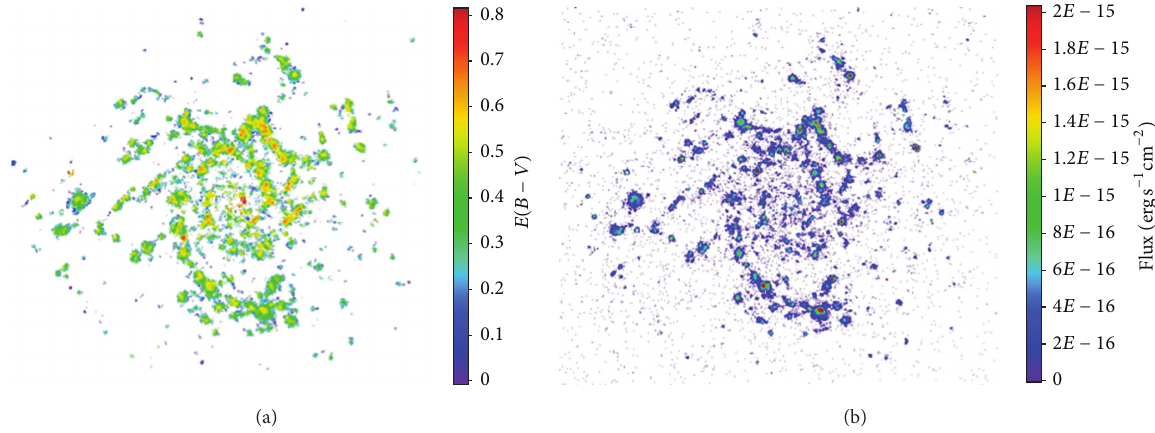
Figure 5: (a) NGC 628 dust extinction map from the H 𝛼 /H 𝛽 ratio. (b) NGC 628 dust-corrected H 𝛼 flux map. Pixel size is 50.5 parsec 2 for a distance of 9.7 Mpc. The field of one CALIFA pointing is shown in the top right corner.